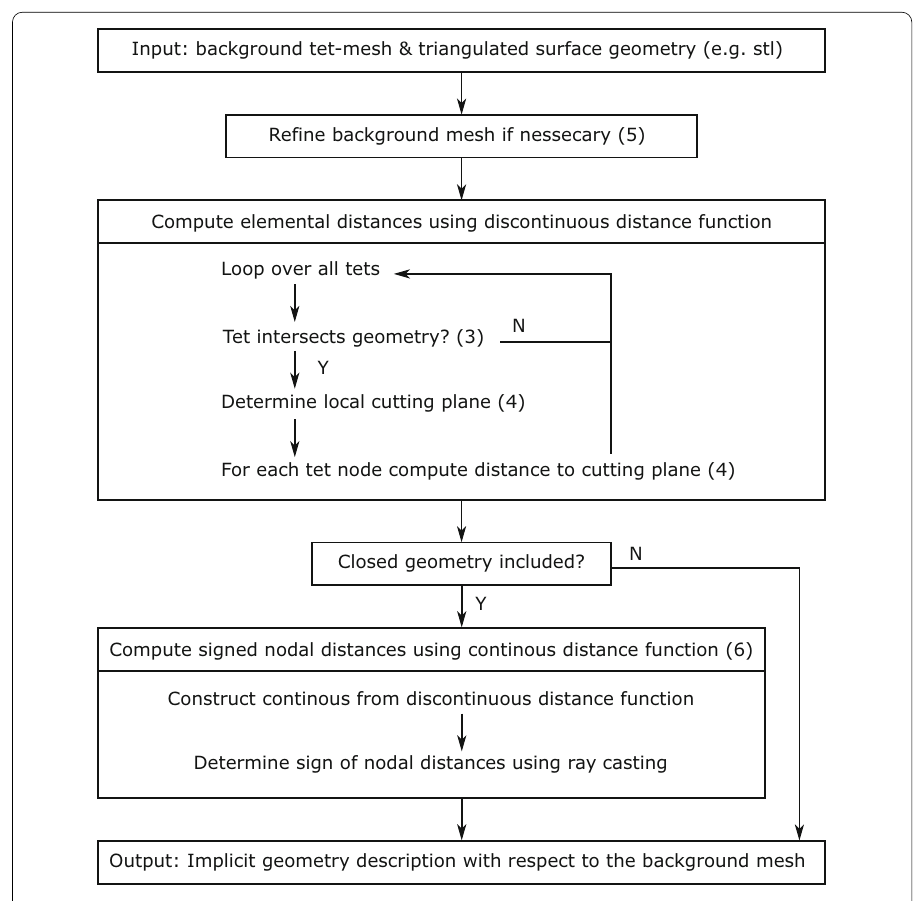
Fig. 4 Algorithm for implicit geometry description based on a combined discontinuous and continuous distance function (sections containing further details are referenced in